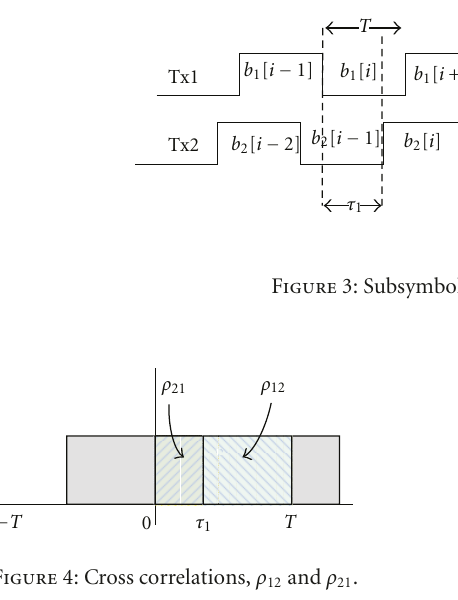
Figure 4: Cross correlations, ρ 12 and ρ 21